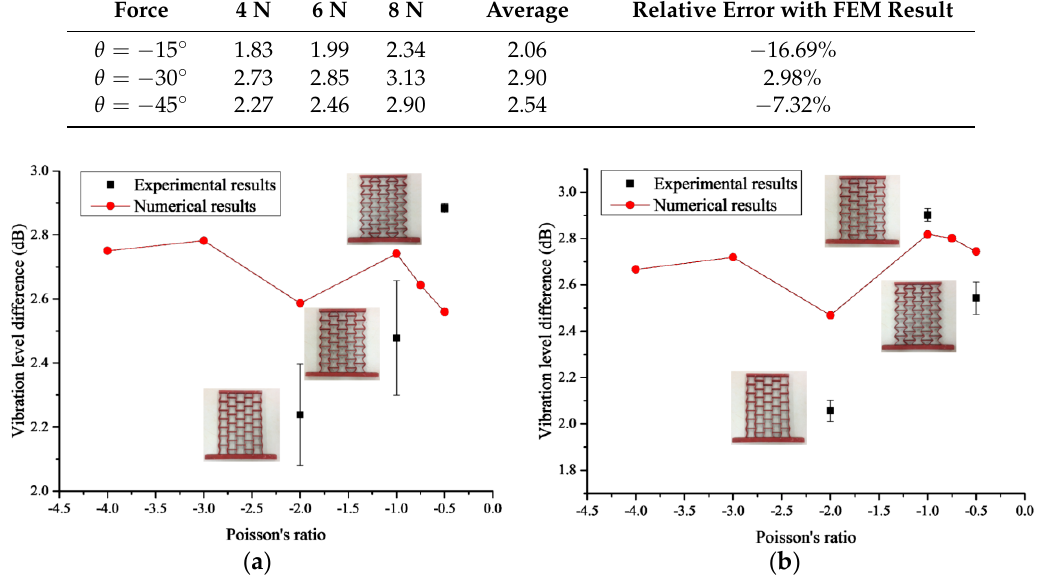
Figure 15. Comparison of the results between the FE models and experiments for different cell thicknesses: ( a ) t = 1 mm and ( b ) t = 2 mm.